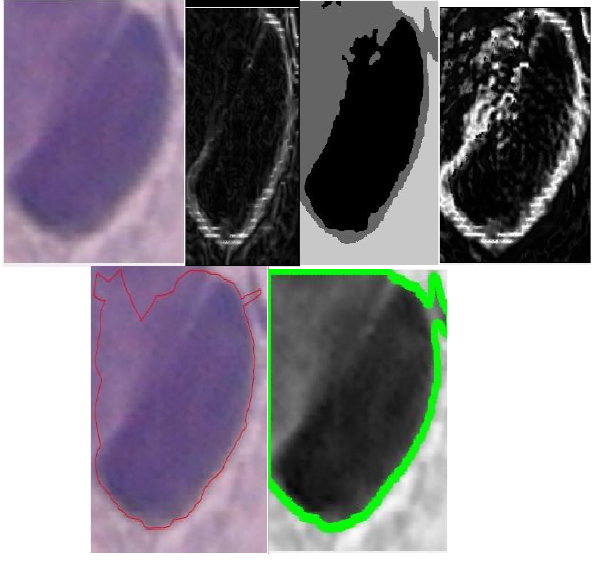
Figure 2. The output images after the enforcement of sequential steps during the implementation of the proposed BKGC-CMSIS scheme